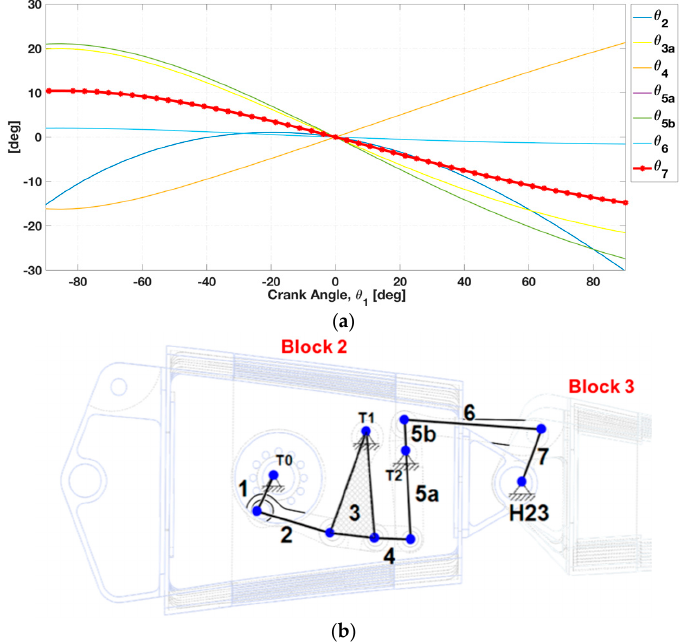
Figure 9. Kinematic design of the inner mechanism: ( a ) Link Angles as function of the crank angle input rotation 𝜃 (cid:2869) ; ( b ) Link lengths within the minimum available design space of the tip TE section.